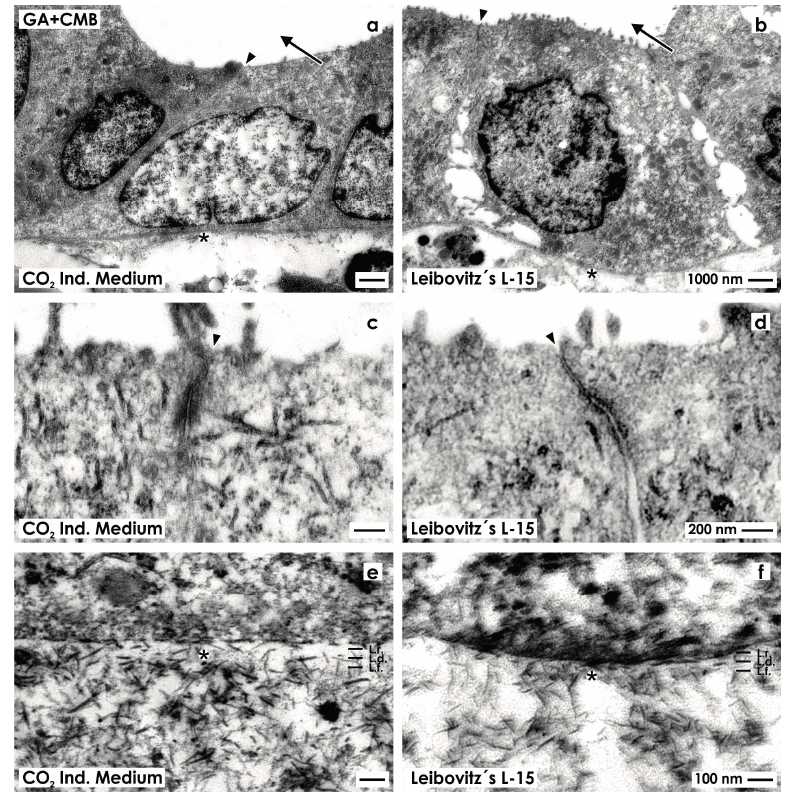
Figure 3. Transmission electron microscopy of renal tubules generated in CO 2 Independent Medium ( a , c , e ) or Leibovitz’s L-15 Medium ( b , d , f ) after fixation in GA solution containing cupromeronic blue (CMB). ( a , b ) Generated tubules show a polarized epithelium with a lumen (arrow) and a basal lamina (asterisk); ( c , d ) Between the luminal and lateral plasma membranes a tight junction (arrow head) is established; ( e , f ) The basal lamina consists of a lamina rara (L.r.), lamina densa (L.d.) and lamina fibroreticularis (L.f.). Within the interstitium numerous braces of proteoglycans are seen that are linked to each